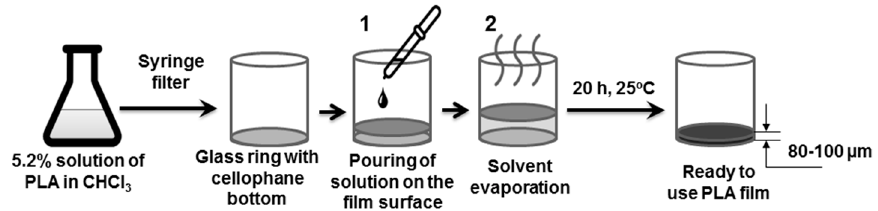
Figure 1. Poly(lactic acid) (PLA-based) film preparation using a glass ring with cellophane bottom: 1—addition of the PLA solution; 2—slow solvent evaporation.